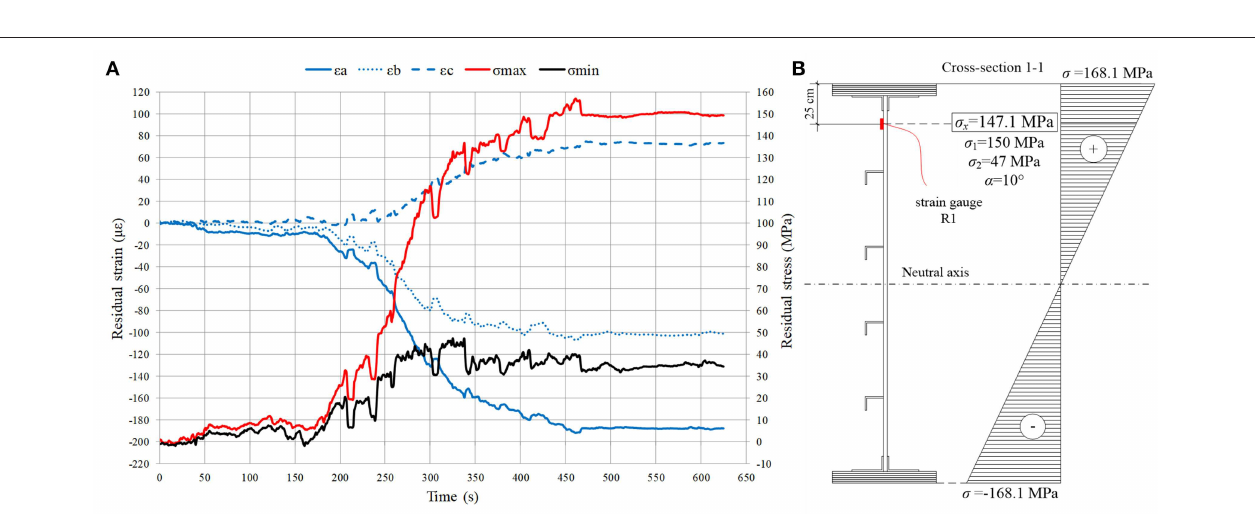
FIGURE 4 | Cross-section 1-1: (A) Measured residual strains and calculated stresses; (B) Estimated residual stress distribution.